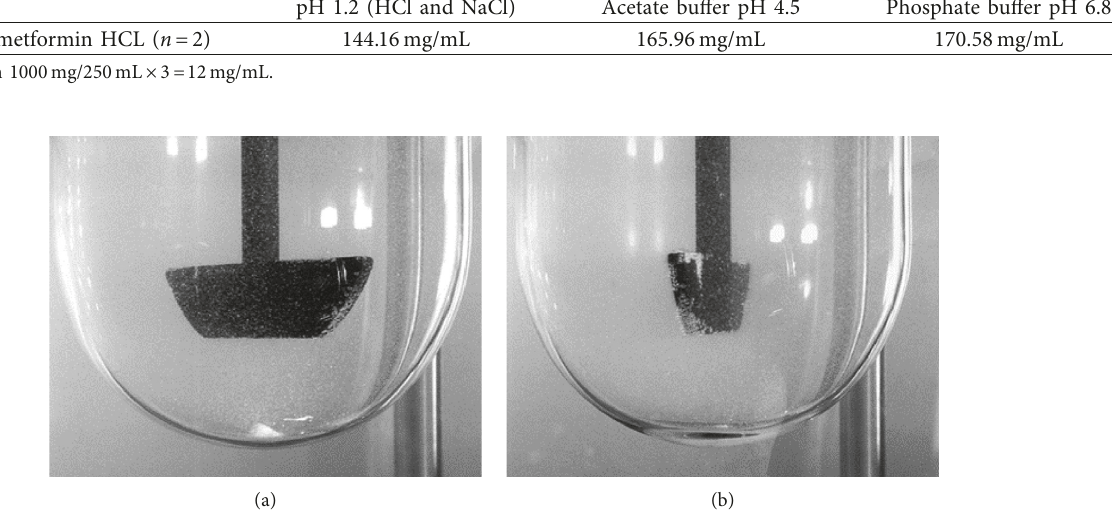
Figure 1: Visual observation of metformin 1000mg film-coated tablets using paddles with rotation speed (a) 50rpm and (b) 75rpm. Table 2: The obtained results of the dissolution test of metformin 1000mg film-coated tablets using different apparatus and volume of the medium.